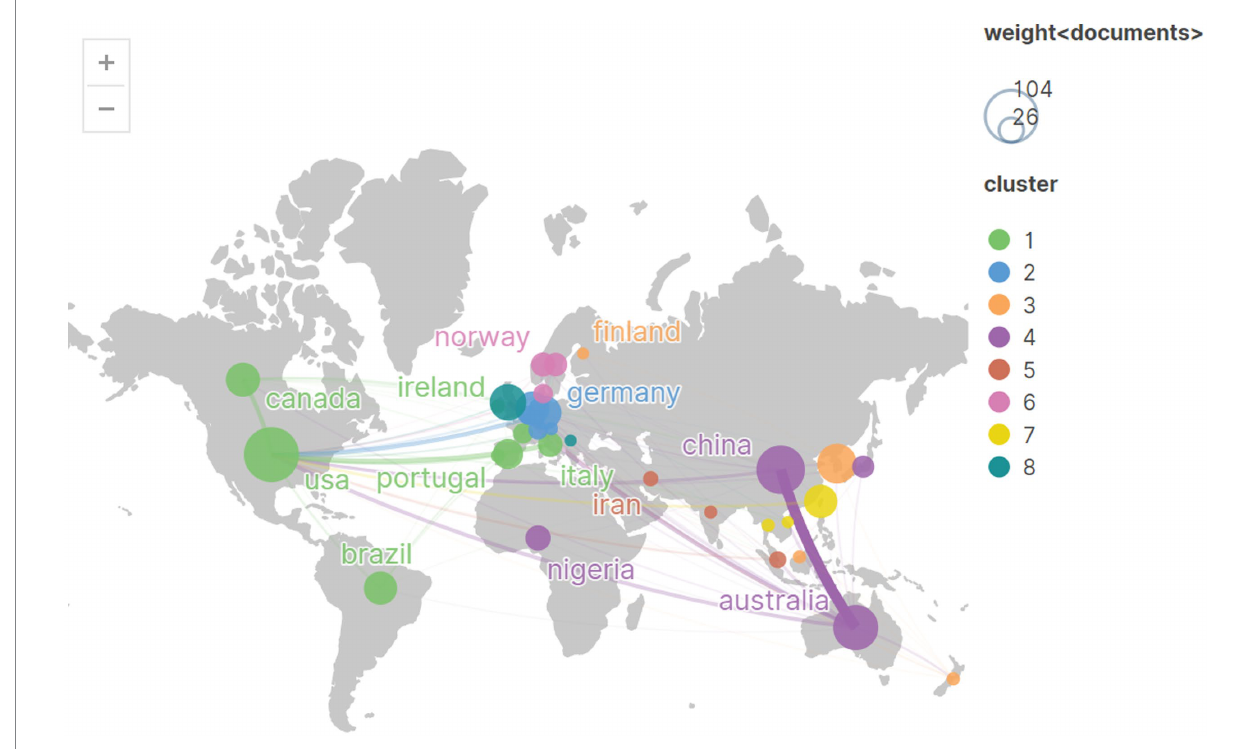
FIGURE 8 The distribution of countries/region.